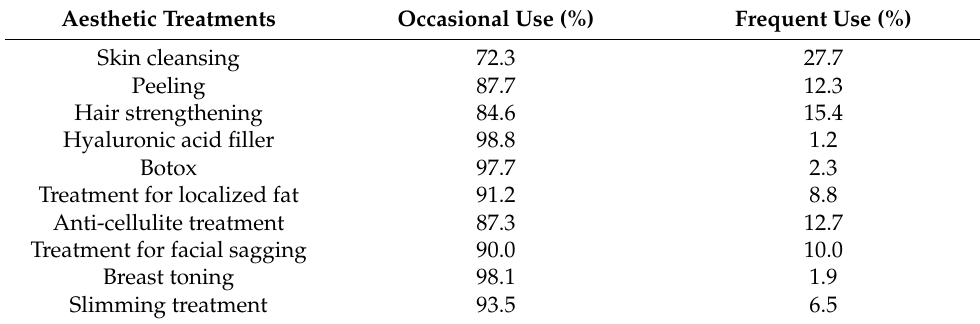
Table 2. Usage patterns of aesthetic